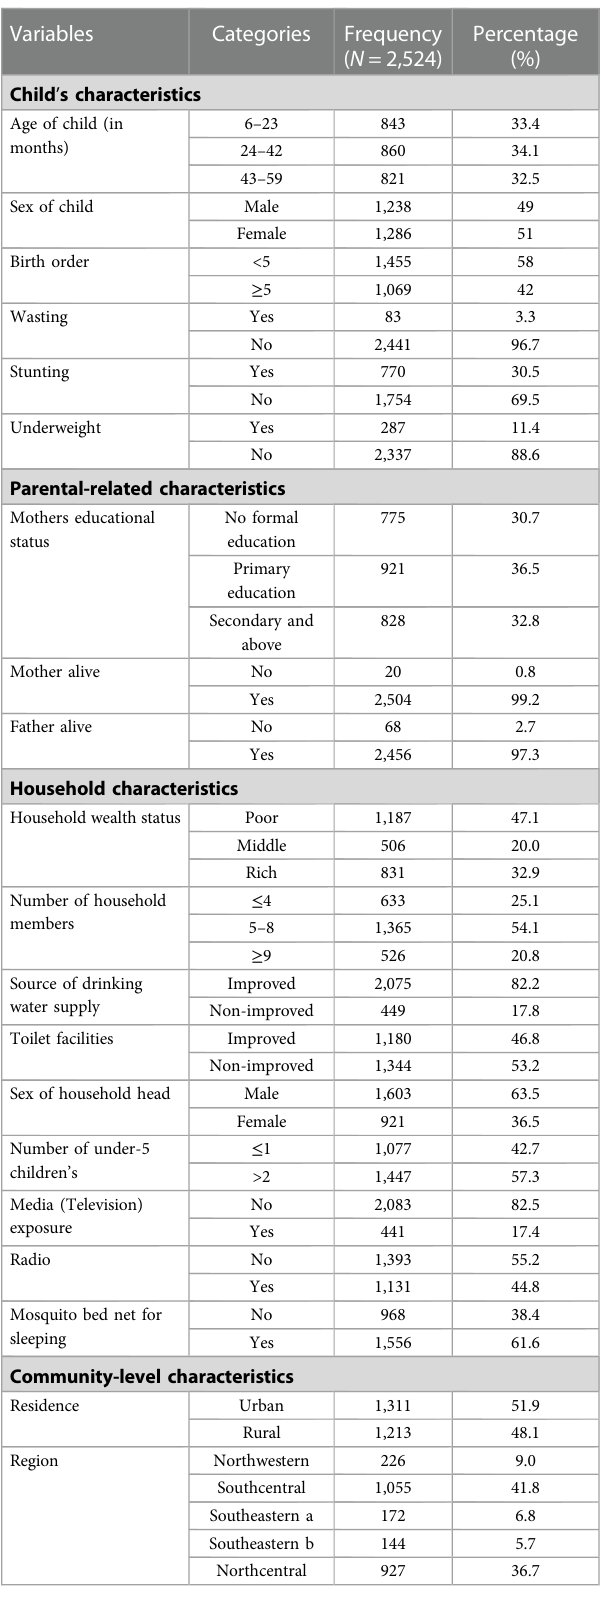
TABLE 1 Descriptive characteristics of study participants in Liberia ( N =